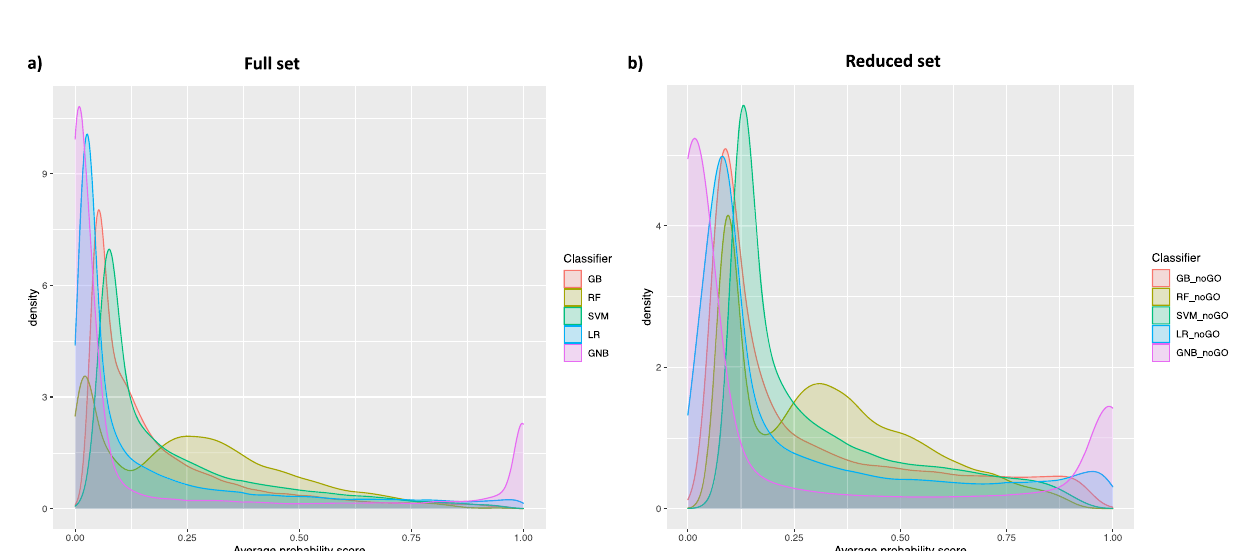
Fig. 2 Model predictions across all human genes. Probability score distributions for Class 1 as obtained in predictive modelling based on the ( a ) full and ( b ) reduced feature